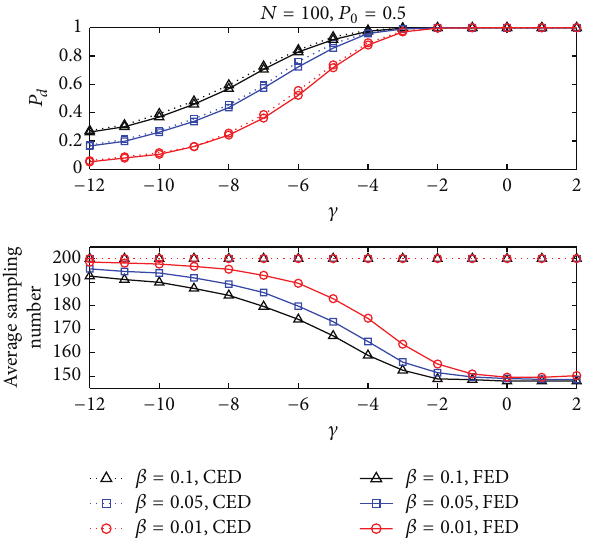
Figure 4: Performance of CED and FED versus 𝛾 under different 𝛽 .